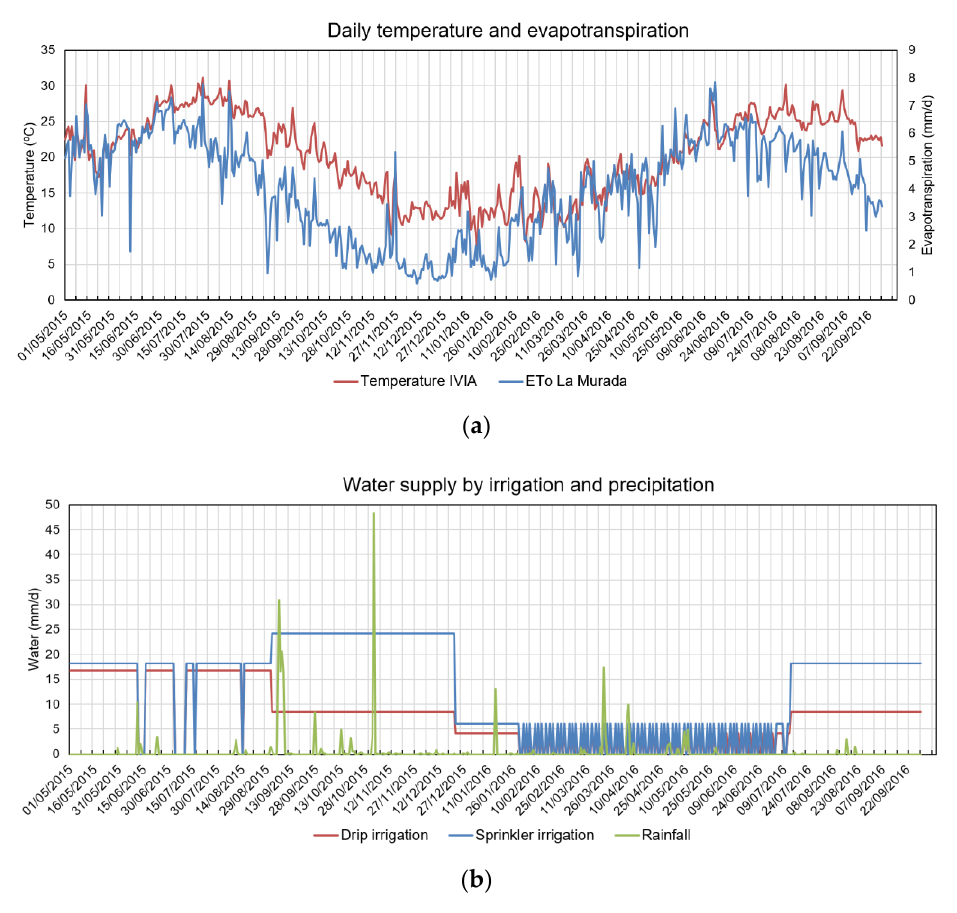
Figure 2. Main agroclimatic and irrigation variables during the study period. The agroclimatic variables were obtained in the station of La Murada; irrigation was obtained in the crop. ( a ) Daily values of the temperature and reference evapotranspiration (ETo). ( b ) Daily values of the water supply by irrigation and rainfall.